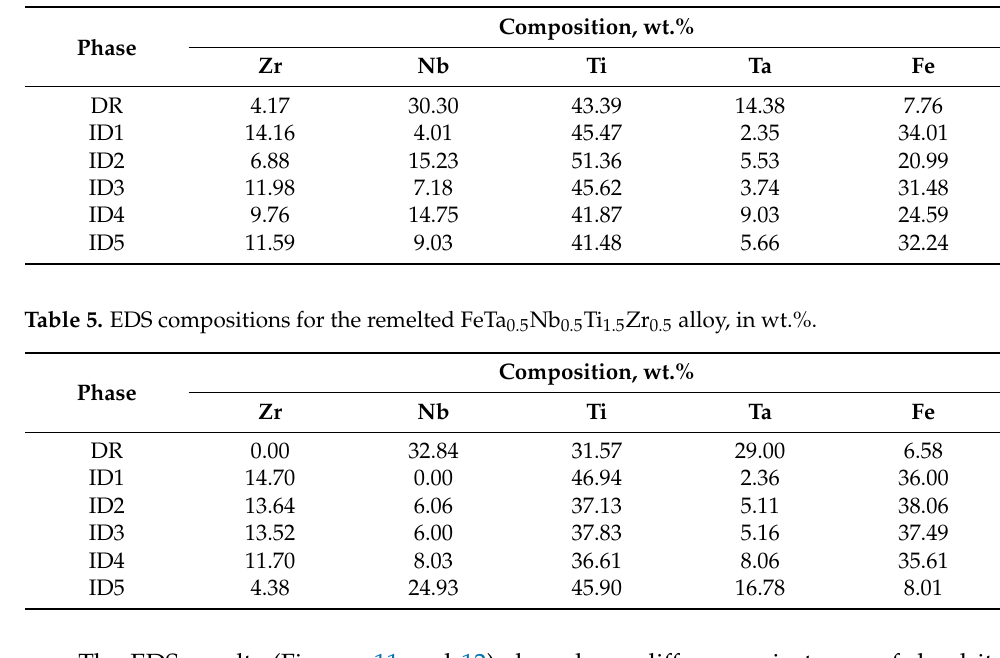
Table 4. Phase compositions for the as-cast FeTa 0.5 Nb 0.5 Ti 1.5 Zr 0.5 alloy.